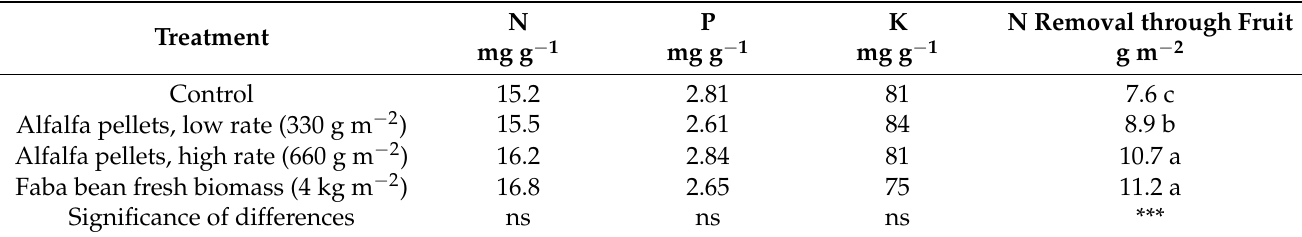
Table 4. The impact of different organic fertilization treatments on fruit N, P, and K dry matter concentrations and N removal by fruit harvesting in organic greenhouse